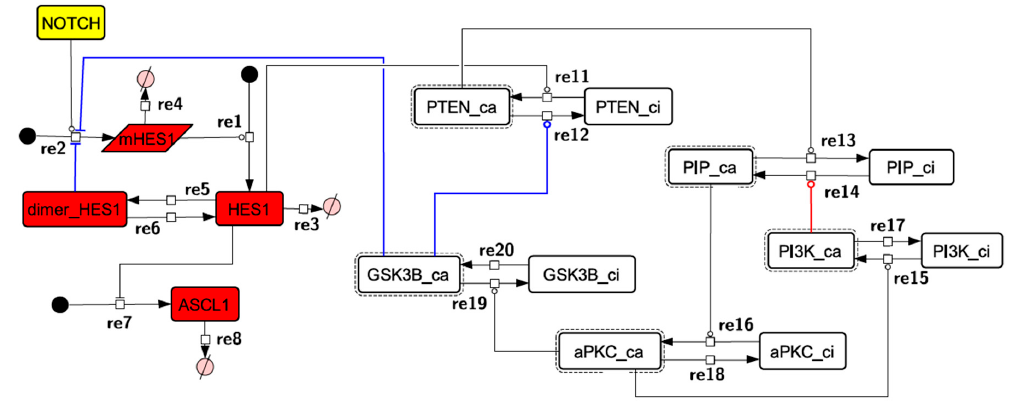
Figure 4. Diagram of the toy model. The model consists of multiple feedback loops extracted from the core signaling network. The red edge is a component of a positive feedback loop. Blue edges are components of negative feedback loops. Node color codes: yellow, receptor; red, transcription factor; white, contracted node. Table 1. Differential equations of the toy model.